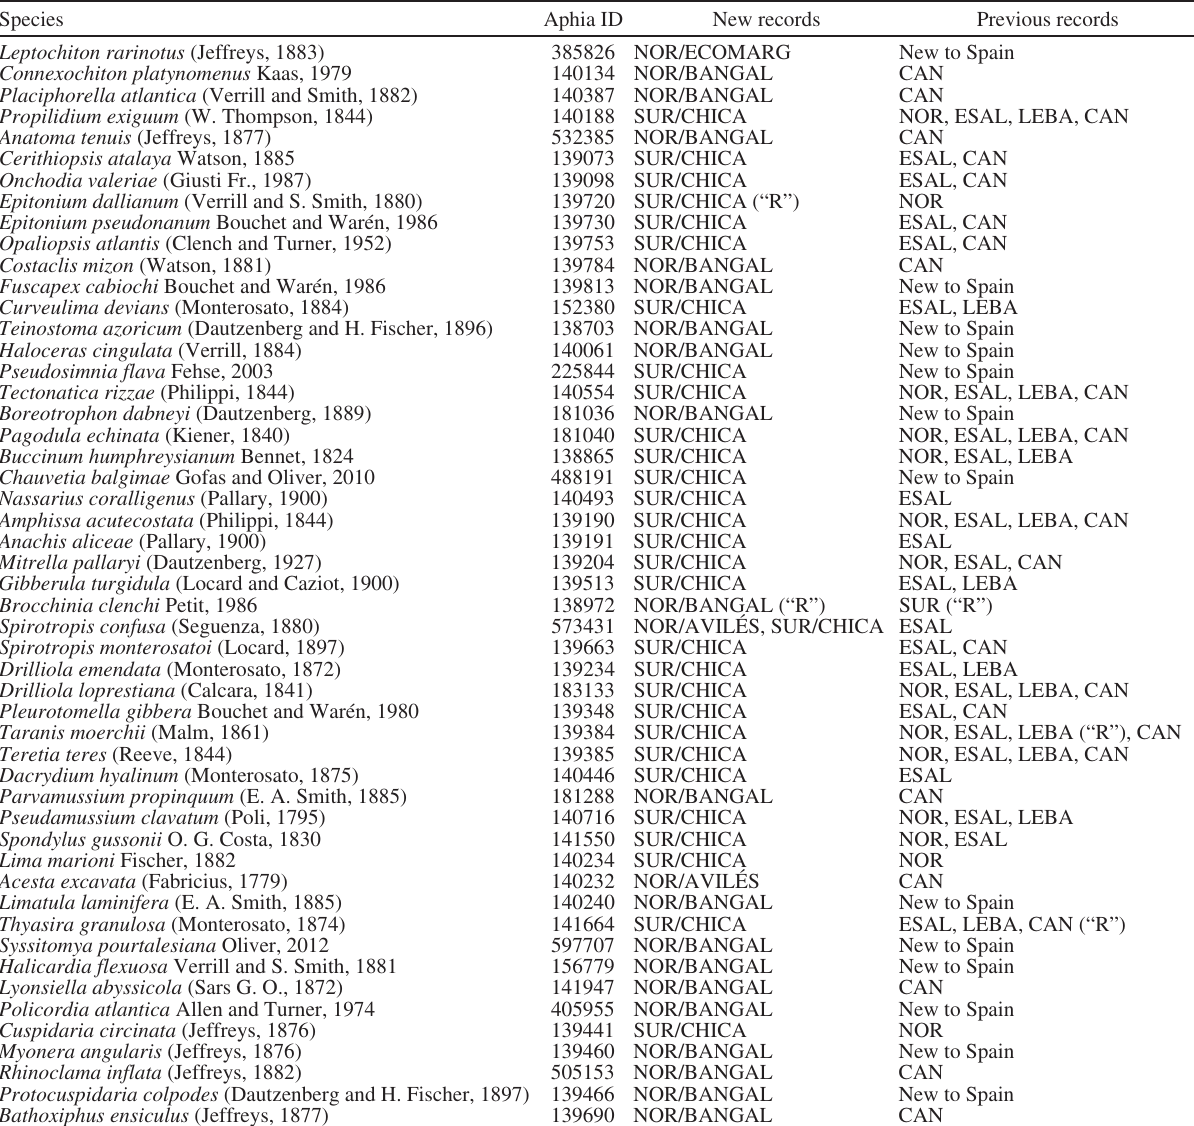
Table 6. – New records of molluscan species from the ECOMARG programme, the INDEMARES AVILÉS, INDEMARES CHICA and